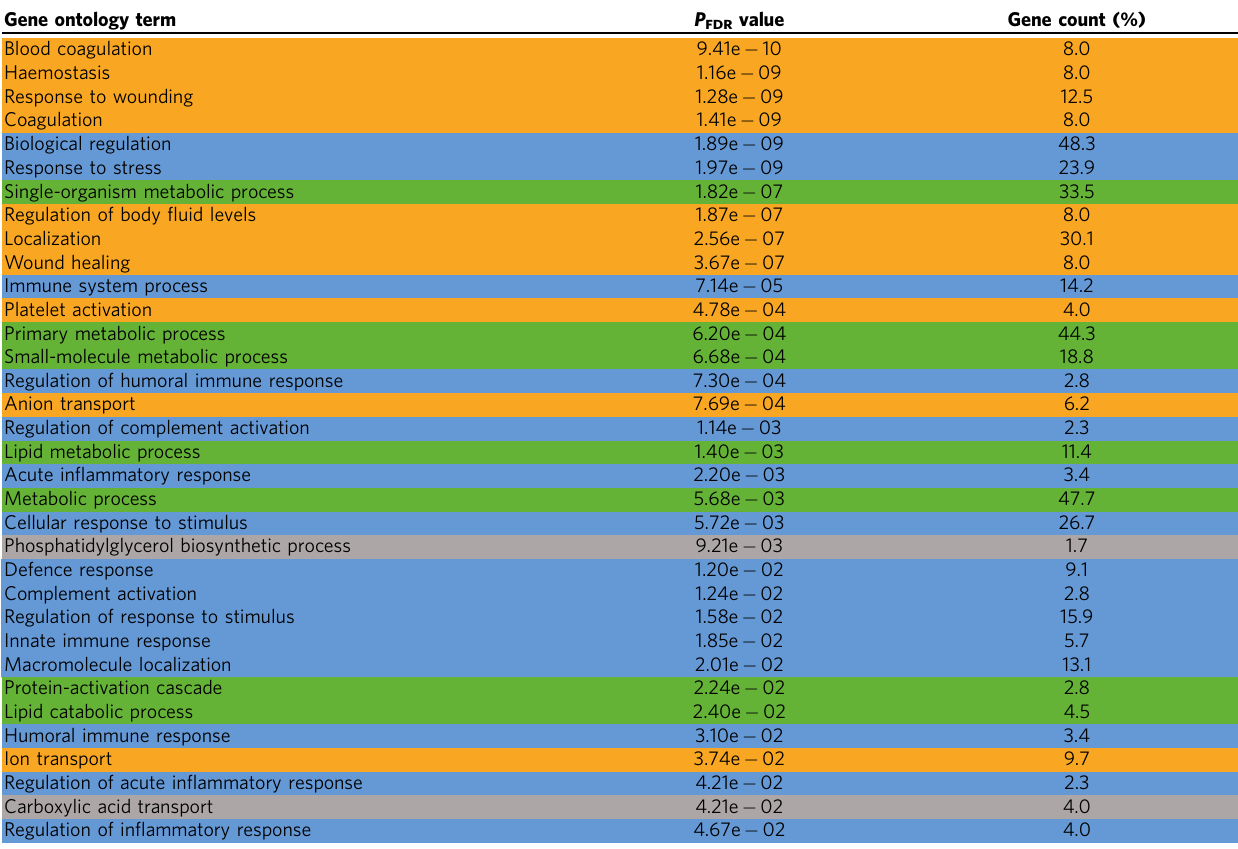
Table 1 | Enriched gene ontology terms among differentially expressed genes. Gene ontology